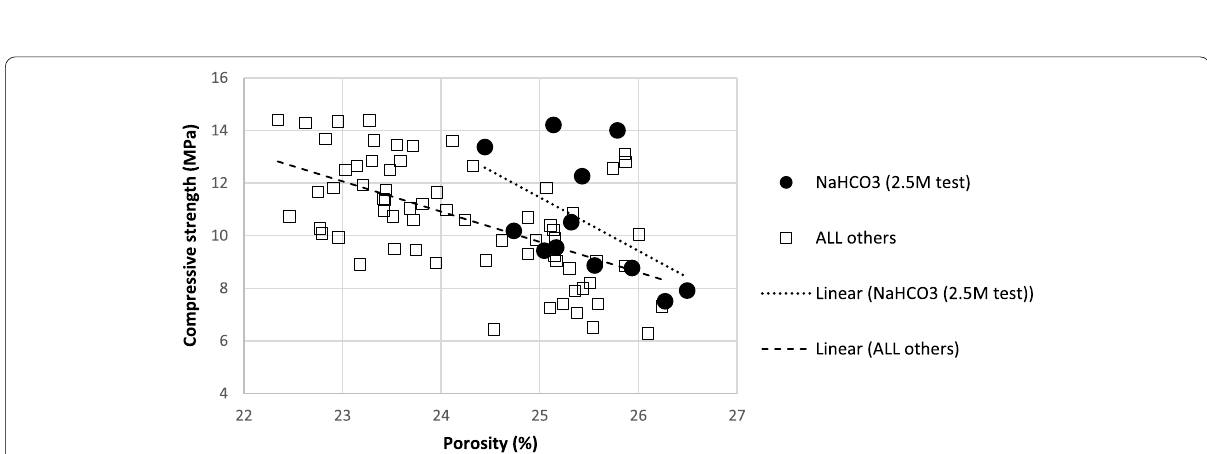
Fig. 4 Compressive strength versus porosity: All specimens, segregated by early or late compressive strength test performance (“X M treat” treated X months after casting; “Y M test” tested Y months after treatment ended) =